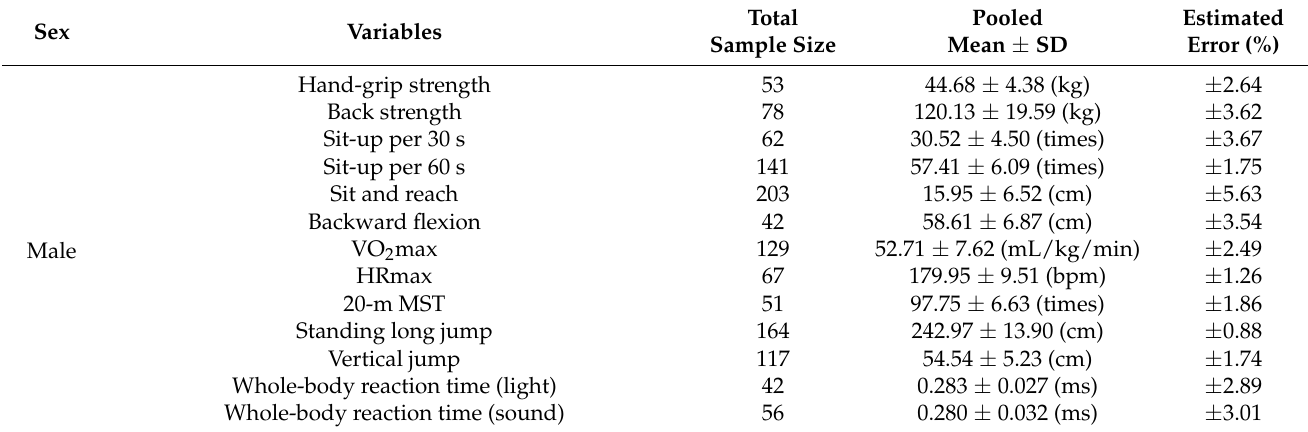
Table 4. Pooled and estimated statistics for the male Taekwondo athletes’ physical